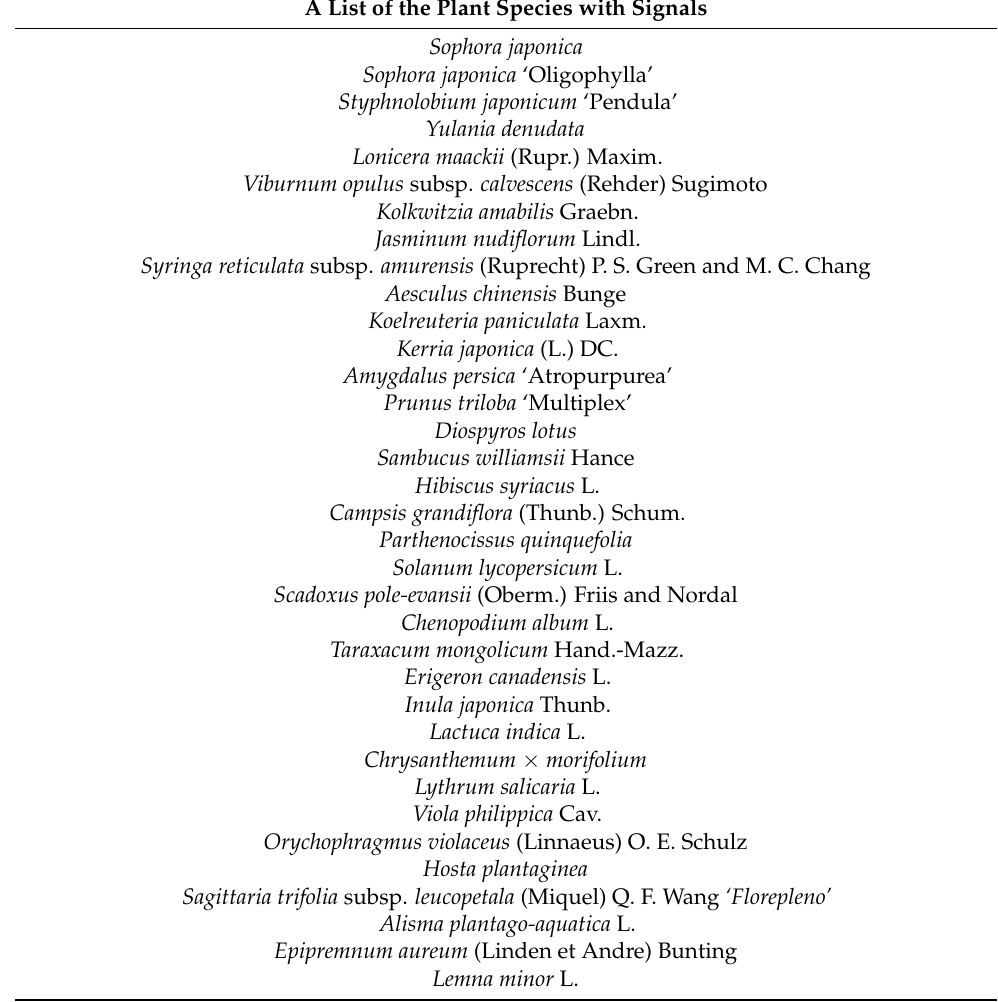
Table 1. A list of the plant species in which the signal of FtsZ1 can be observed with this improved immunofluorescence staining